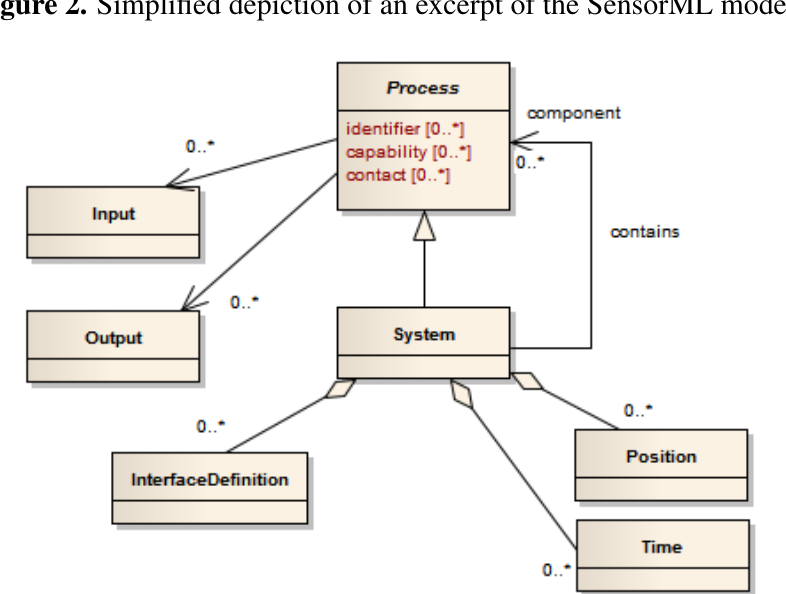
Figure 2. Simplified depiction of an excerpt of the SensorML